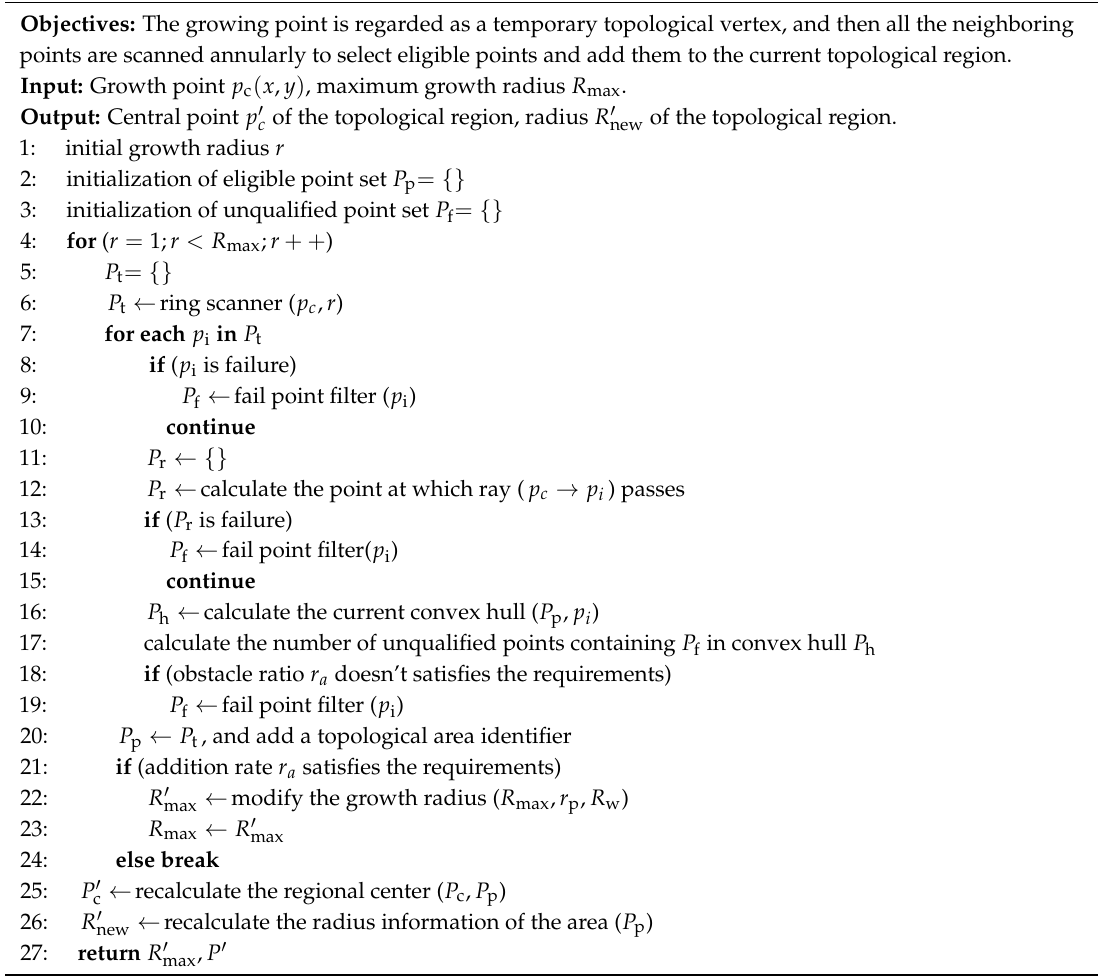
Algorithm 1: Regional dynamic